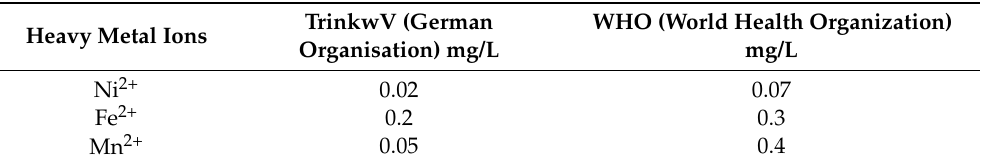
Table 1. Heavy metal ion limit values in drinking water according to the German drinking water ordinance (TrinkwV) [11] and WHO